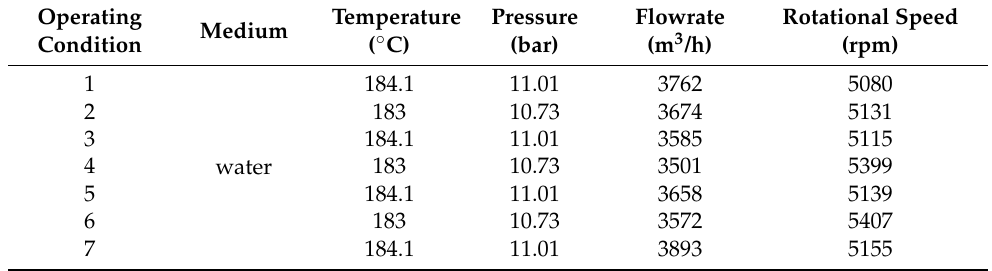
Table 2. Main operating parameters.